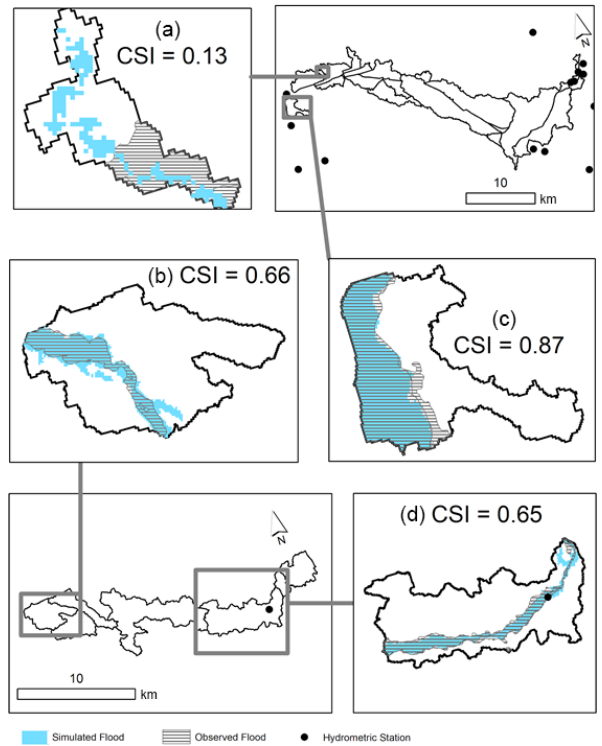
Figure 8. Simulated flood and insets – Grand River watershed 100- year return period.